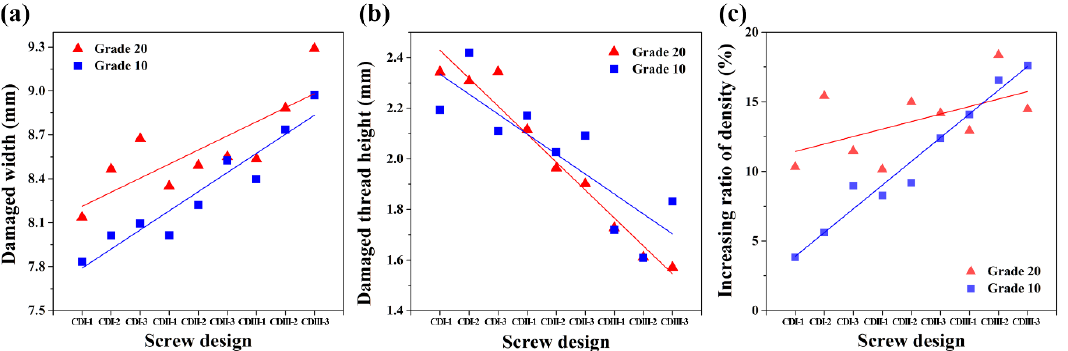
Figure 11. ( a ) damaged width, ( b ) damaged thread height, and ( c ) increasing ratio of density of the artificial bone with the screw removed after the pullout artificial bone with the screw removed after the pullout test.